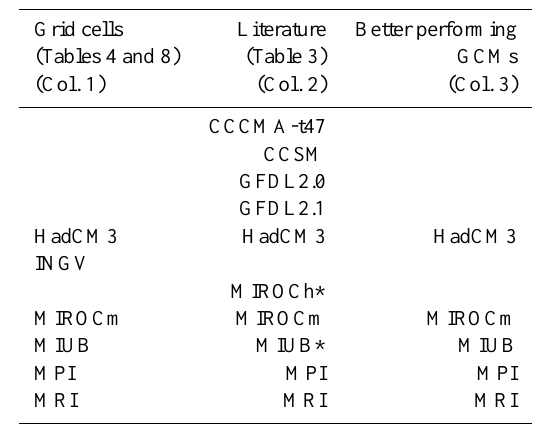
Table 9. Better performing CMIP3 GCMs identified from the liter- ature and our analyses.